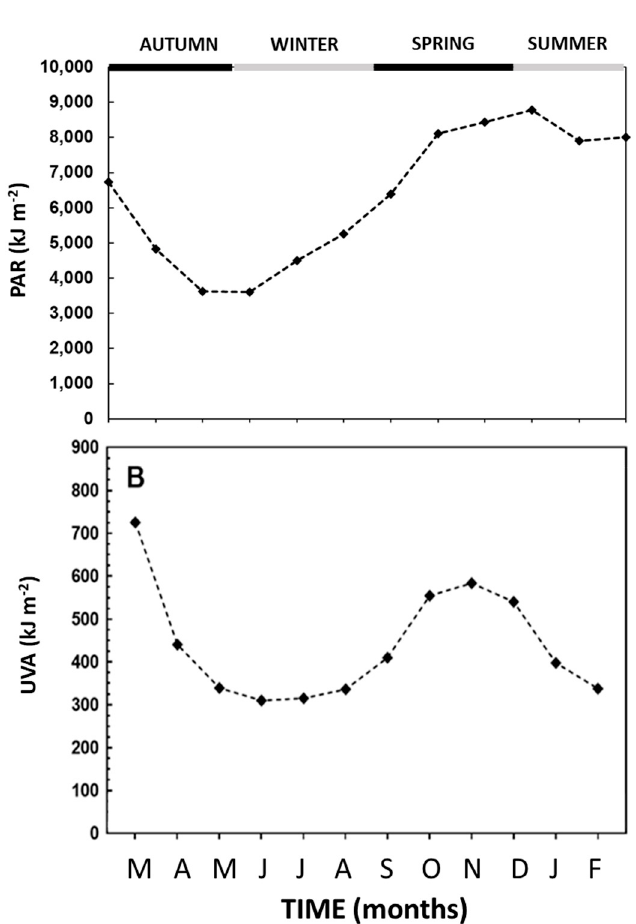
Figure 1. (Daily integrated irradiance (doses) of ( A ) Photosynthetically active radiation (PAR), expressed in KJm − 2 and ( B ) Ultraviolet A (UVA) expressed in KJm − 2 , measured at the monitoring